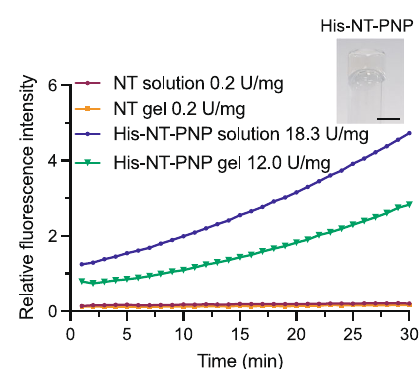
Fig. 6 | NT fusion proteins form hydrogels with intact activity of the fusion partner. a Relative fl uorescence intensity before and after gelation of His-NT- GFP (300mg/ml) and inverted vials containing His-NT-GFP hydrogels (300mg/ ml) under visible and UV light. Dots show individual measurements ( n =3) and error bars show standard deviation. Center of the error bar shows the mean.